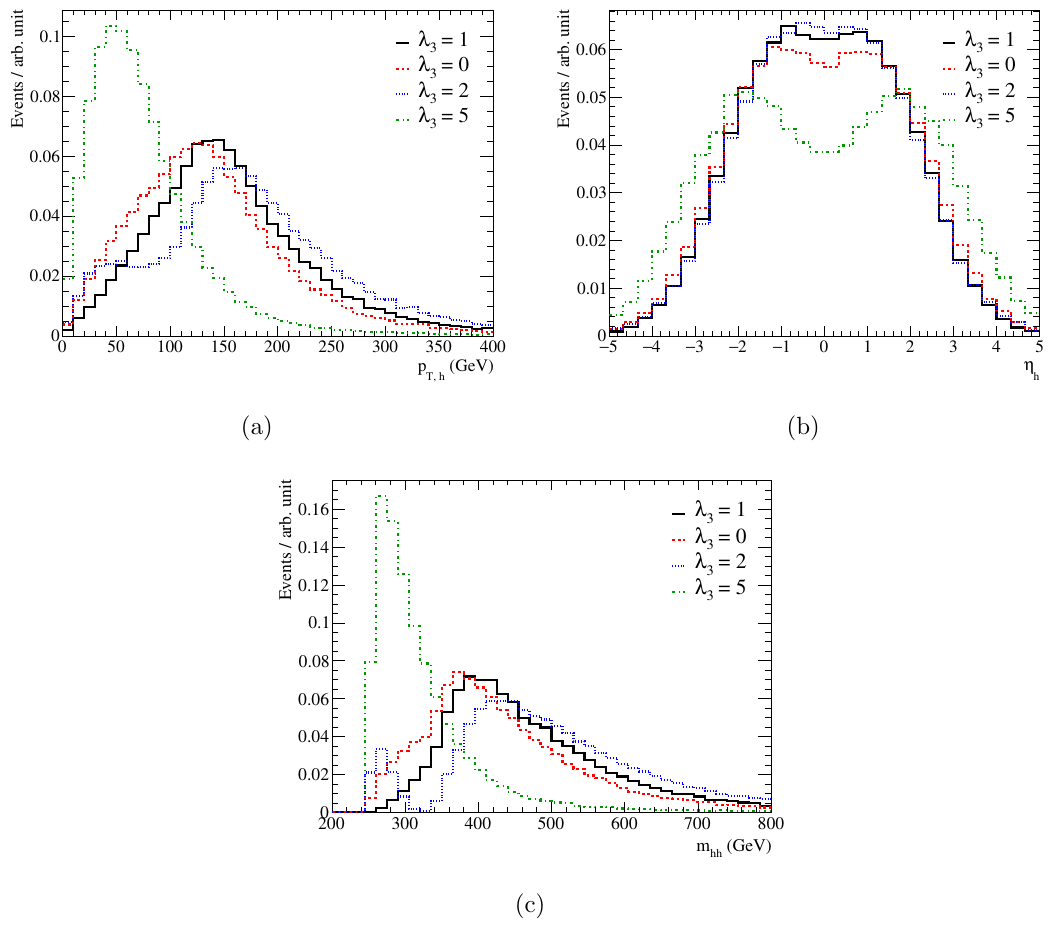
Figure 2. (a): the transverse-momentum distribution of the true Higgs bosons generated in our 27 TeV samples, prior to showering and detector smearing, for several di(cid:11)erent values of (cid:21) 3 . (b): the same, but for the Higgs pseudorapidity. (c): the same, but for the distribution of the true Higgs pair invariant